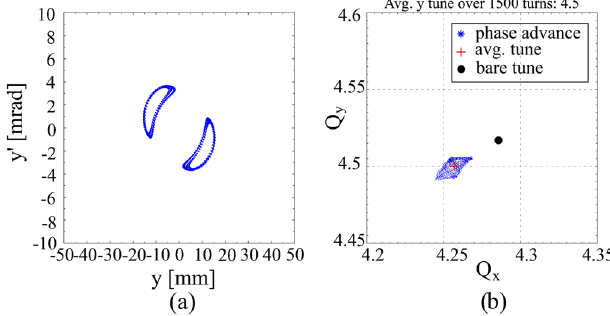
FIG. 16. A particle trapped into quadrupolar islands at 565 ms [on the solid magenta line in Fig. 4(a)]. The turn-by-turn tracking is represented with blue dots in the vertical phase space (a) and in the tunes plane